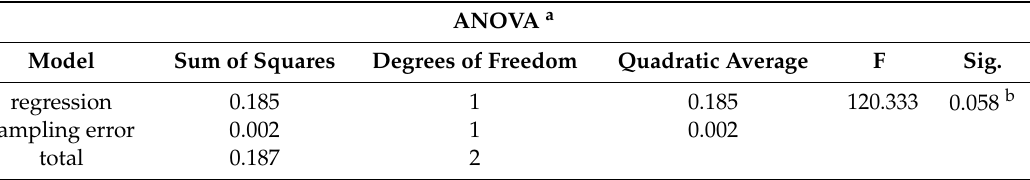
Table 17. Analysis of variance: Wheel-tracking test and relationship between second and first moduli of the plate bearing test (Ev 2 / Ev 1